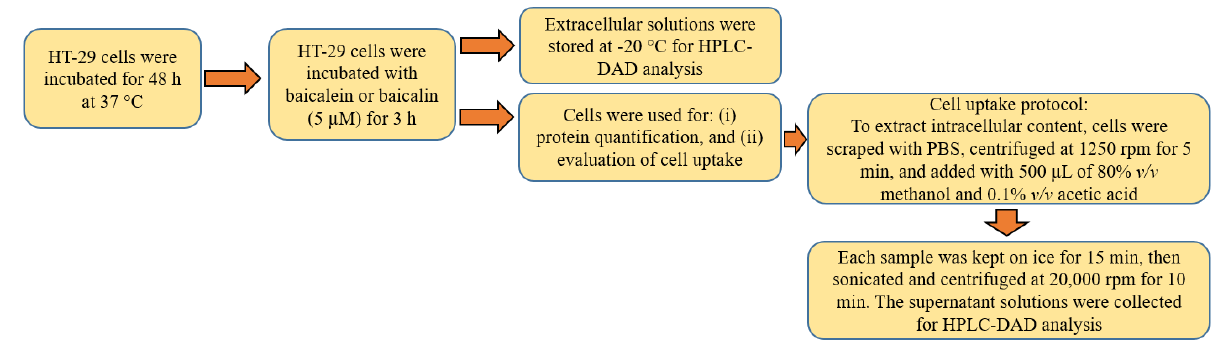
Figure 11. Flowchart of the experimental protocol used to assess the cell uptake of baicalein and baicalin.